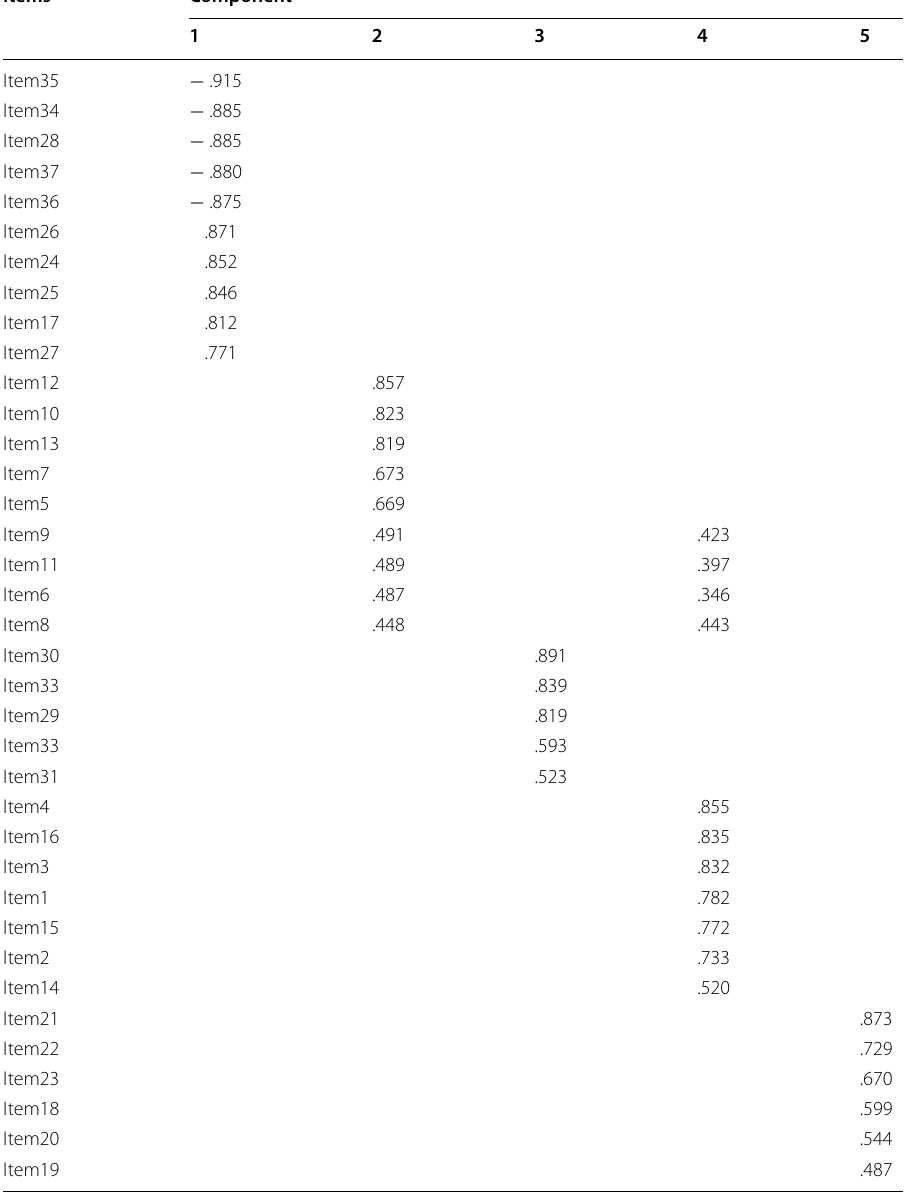
Table 4 Rotated factor matrix a in